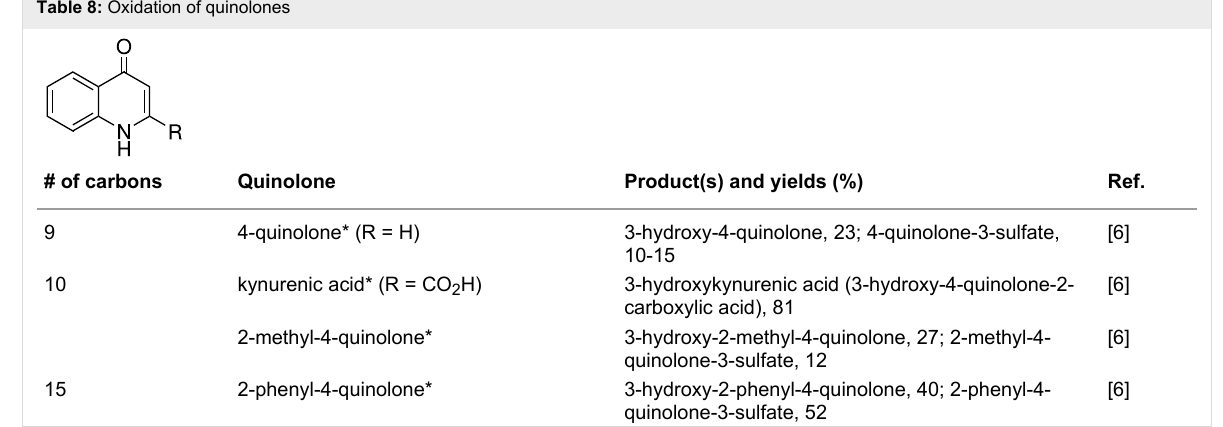
Table 8: Oxidation of quinolones